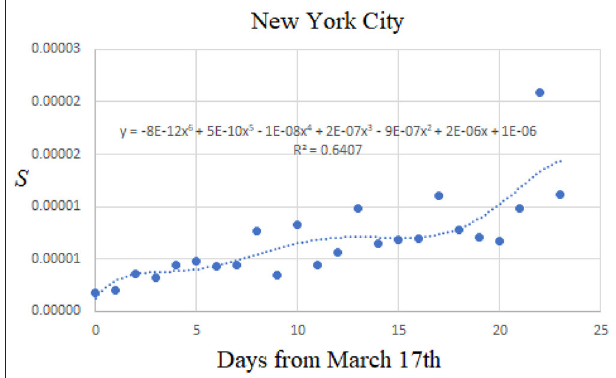
FIGURE 3 | Depicted is the entropy shape for newly SARS-Cov-2 infected people in New York City, in relation to the total number of citizens. From the curve’s best fit, one can evaluate the data of maximum infection probability. For New York City the maximum spread of coronavirus infection is forecasted to occur on the 38th day after March 27th, i.e., on April 25th Data recoiled on https://www1.nyc.gov/site/doh/covid/covid-19-data-archive.page (April 11th,